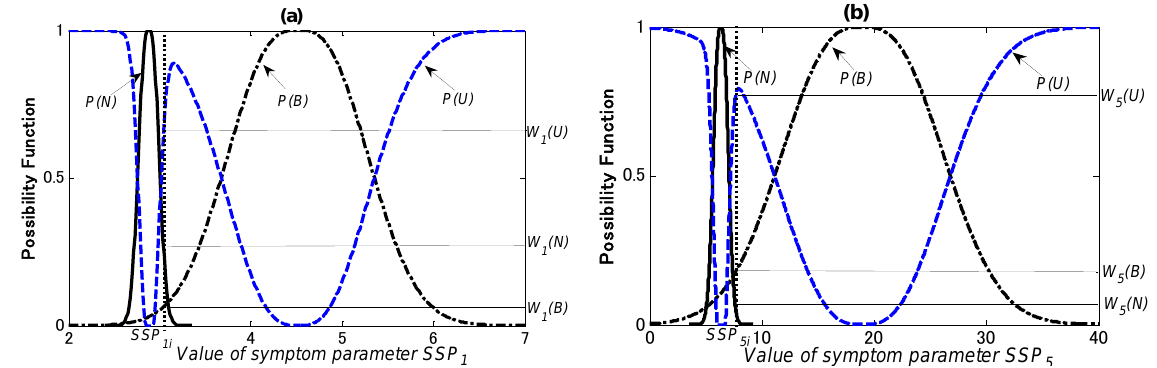
and ( b ) SSP for first diagnostic step. 1 5